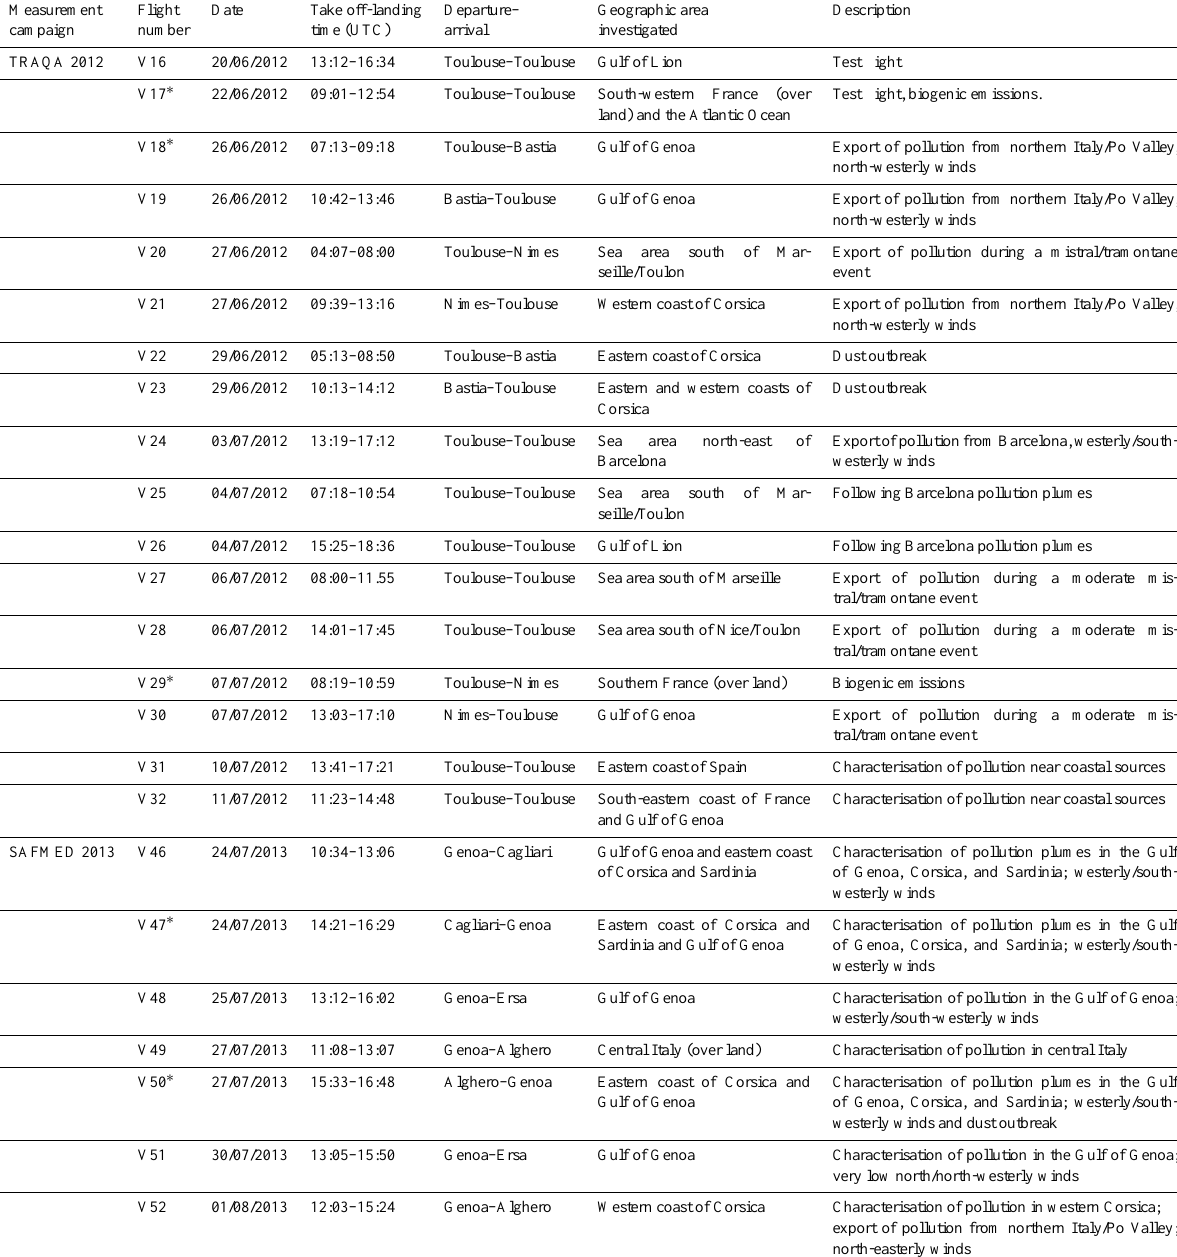
Table 1. Summary of information on the TRAQA and SAFMED flights.